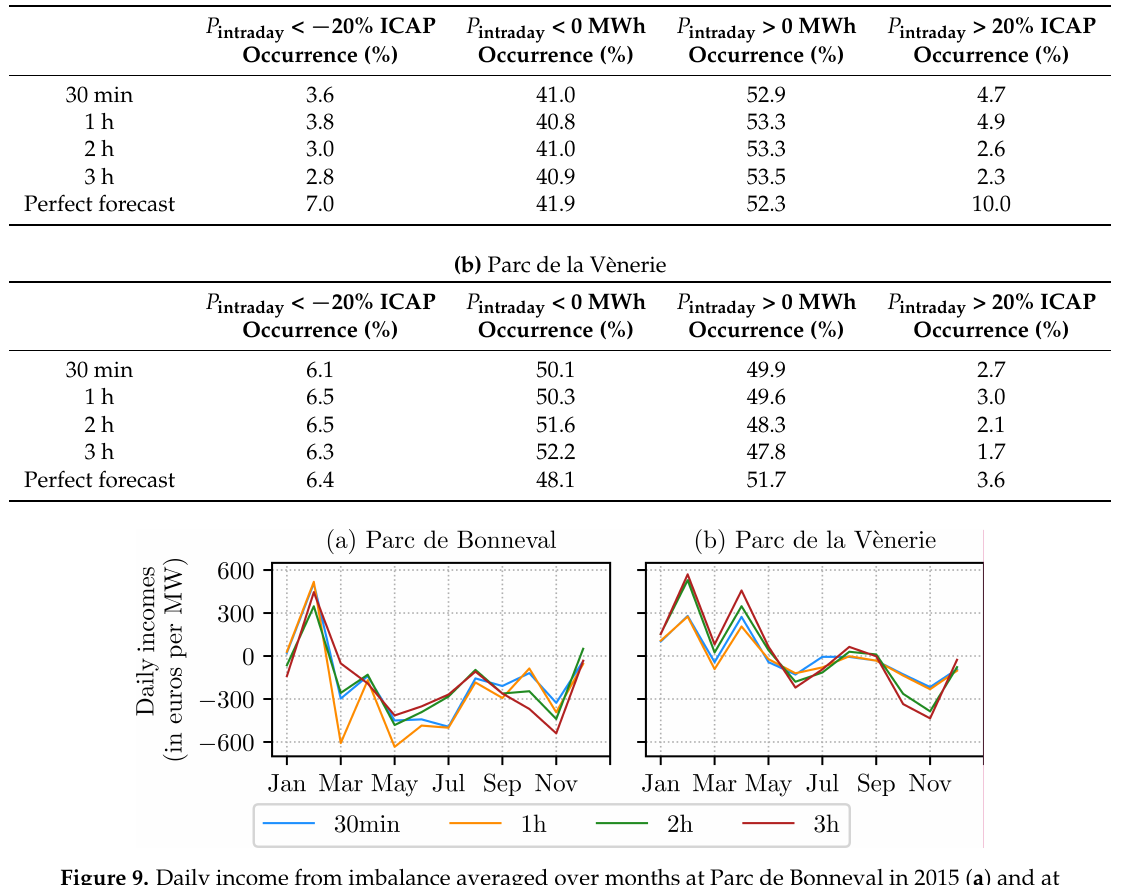
Table 3. Occurrence of P intraday above or below various thresholds, where P intraday is defined as the difference between the production nowcast and the production sold in the day-ahead market. Occurrences of large negative errors ( P intraday < 20% ICAP), moderate negative − errors ( P intraday < 0 MWh), moderate positive errors ( P intraday > 0 MWh) and large positive errors ( P intraday > 20% ICAP) are indicated for Parc de Bonneval and Parc de la Vènerie and four balancing